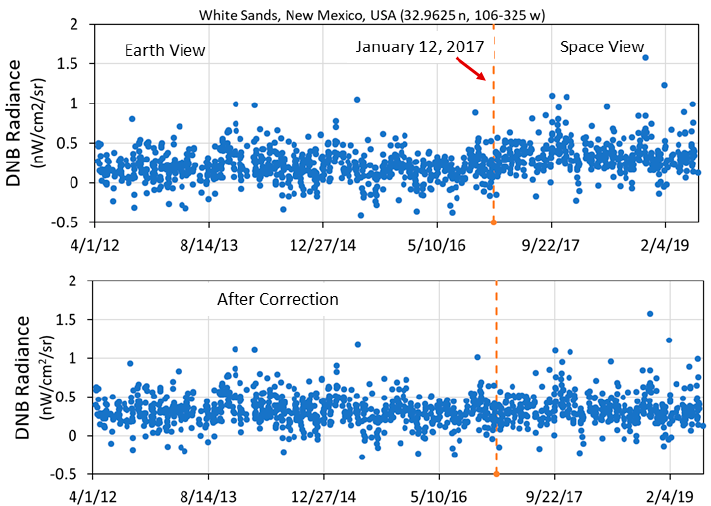
Figure 5. The source used for the dark offset in the DNB radiance calculation changed from an earth view to a space view on 12 January 2017, resulting in a slight upward shift in the radiance. This can be seen visually in the DNB temporal profiles that lack surface lighting or have extremely dim surface lighting. We apply a radiance adjustment of +0.125 nW to the pixels acquired prior the 12 January 2017.